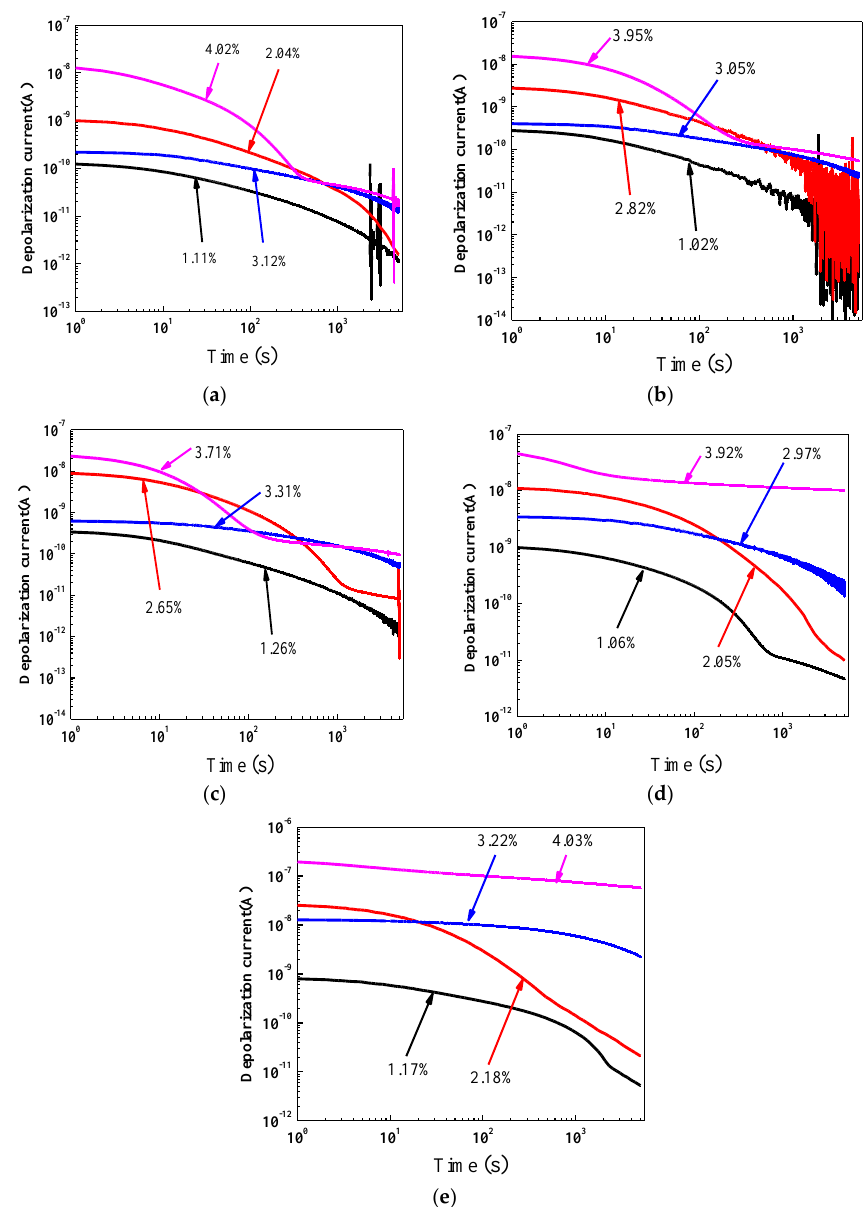
Figure 10. Depolarization current results of oil-impregnated pressboards with different water contents. ( a ) Ageing for 0 day; ( b ) Ageing for 8 days; ( c ) Ageing for 21 days; ( d ) Ageing for 32 days; ( e ) Ageing for 42 days.